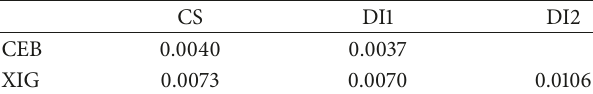
Table 5: The standard deviation (STD) of the theoretical prices of the CEB and XIG convertible bonds calculated the CS method and the DI method with supposition that a default may occur only on the maturity date (DI1), and prior to or on the maturity